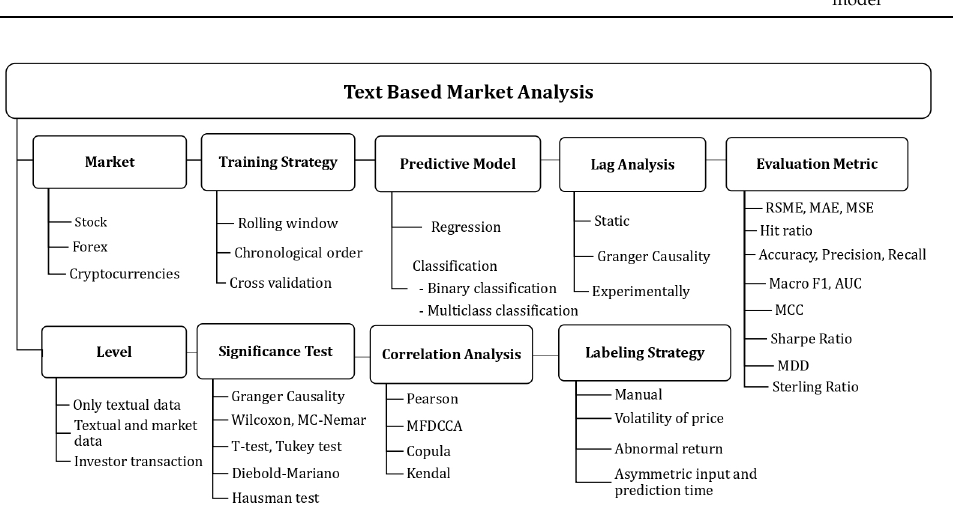
Figure 7. Taxonomy of trait for text-based market analysis